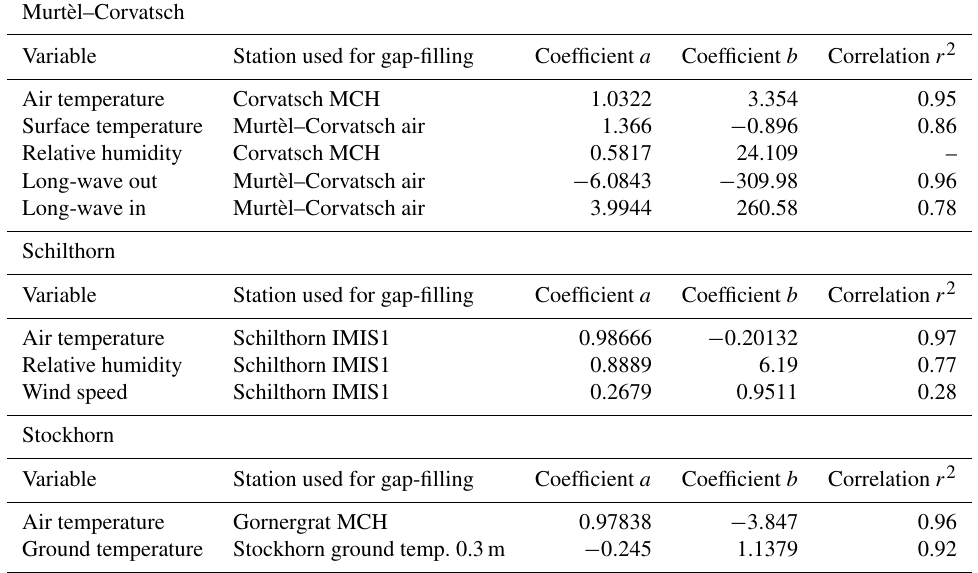
Table 2. Information on the linear regression coefficients used for the gap-filling of level 2 data (MCH: MeteoSwiss; IMIS: Intercantonal Measurement and Information